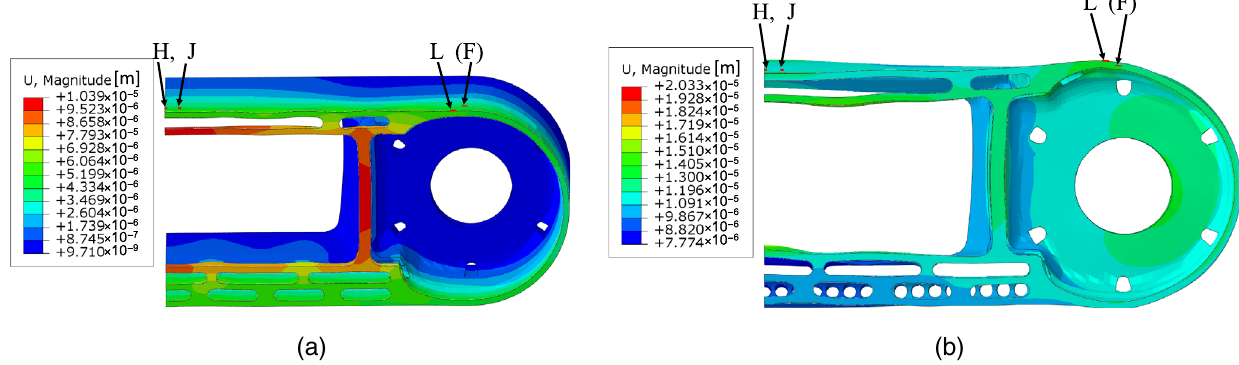
FIG. 17. Deformed shape (magnified 500 ×) of the front body at the back sensor section at 0.15 ms (a) and 0.3 ms